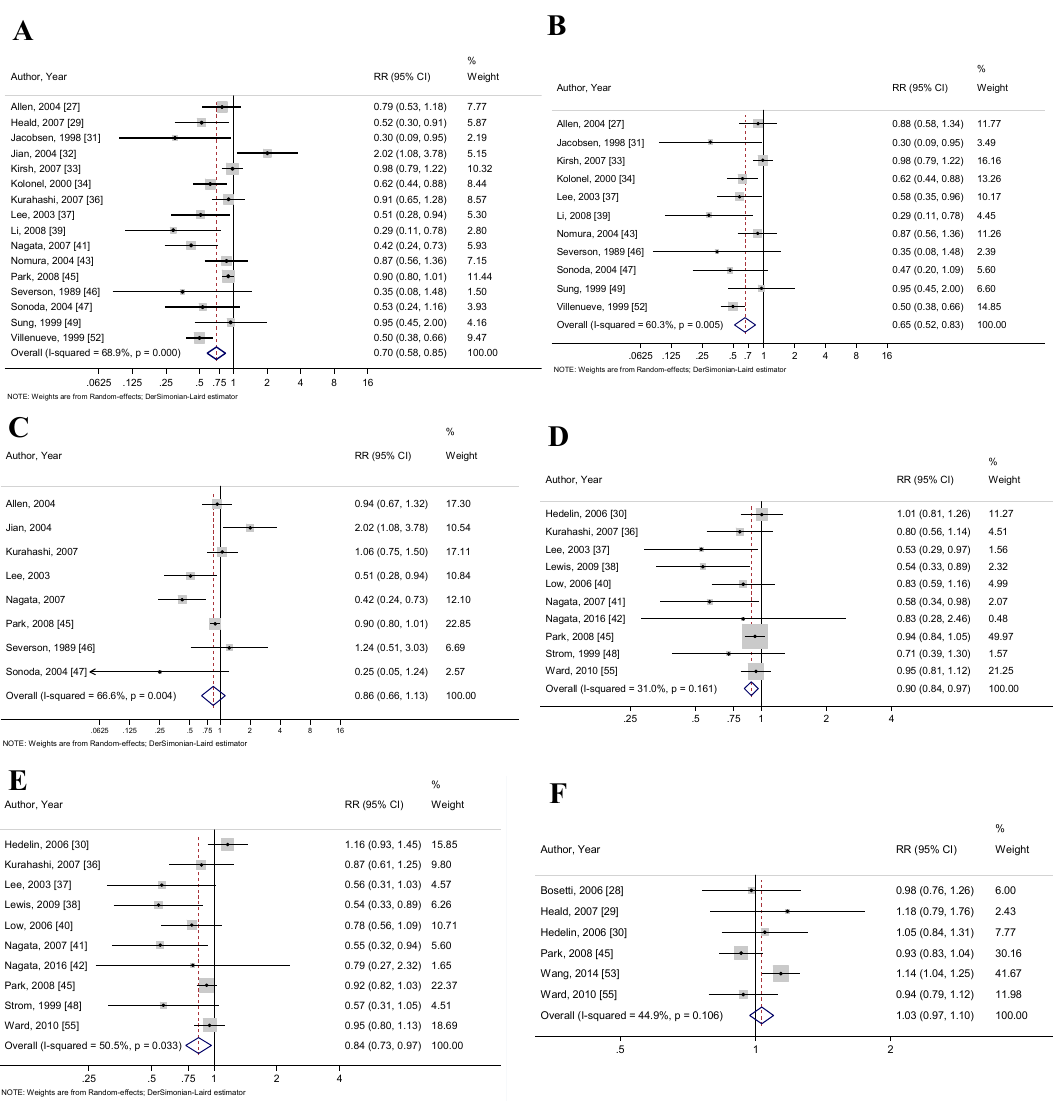
Figure 2. Forest plots for ( A ) total soy intake and risk of prostate cancer; ( B ) unfermented soy intake and risk of prostate cancer; ( C ) fermented soy intake and risk of prostate cancer; ( D ) genistein intake and risk of prostate cancer; ( E ) daidzein intake and risk of prostate cancer; and ( F ) total isoflavone intake and risk of prostate cancer. These associations were indicated as a relative risk (RR) estimate with the corresponding 95% confidence interval (CI).